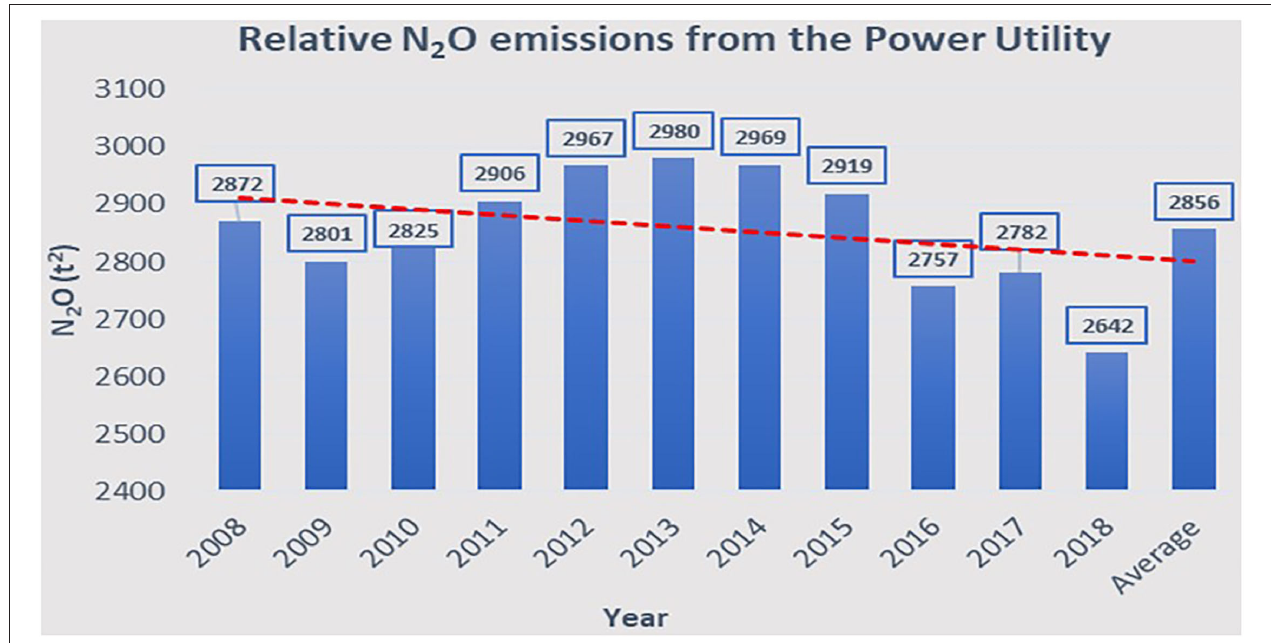
FIGURE 5 | Relative N 2 O produced during fuel-burning electricity generation process. Source: Data from Eskom